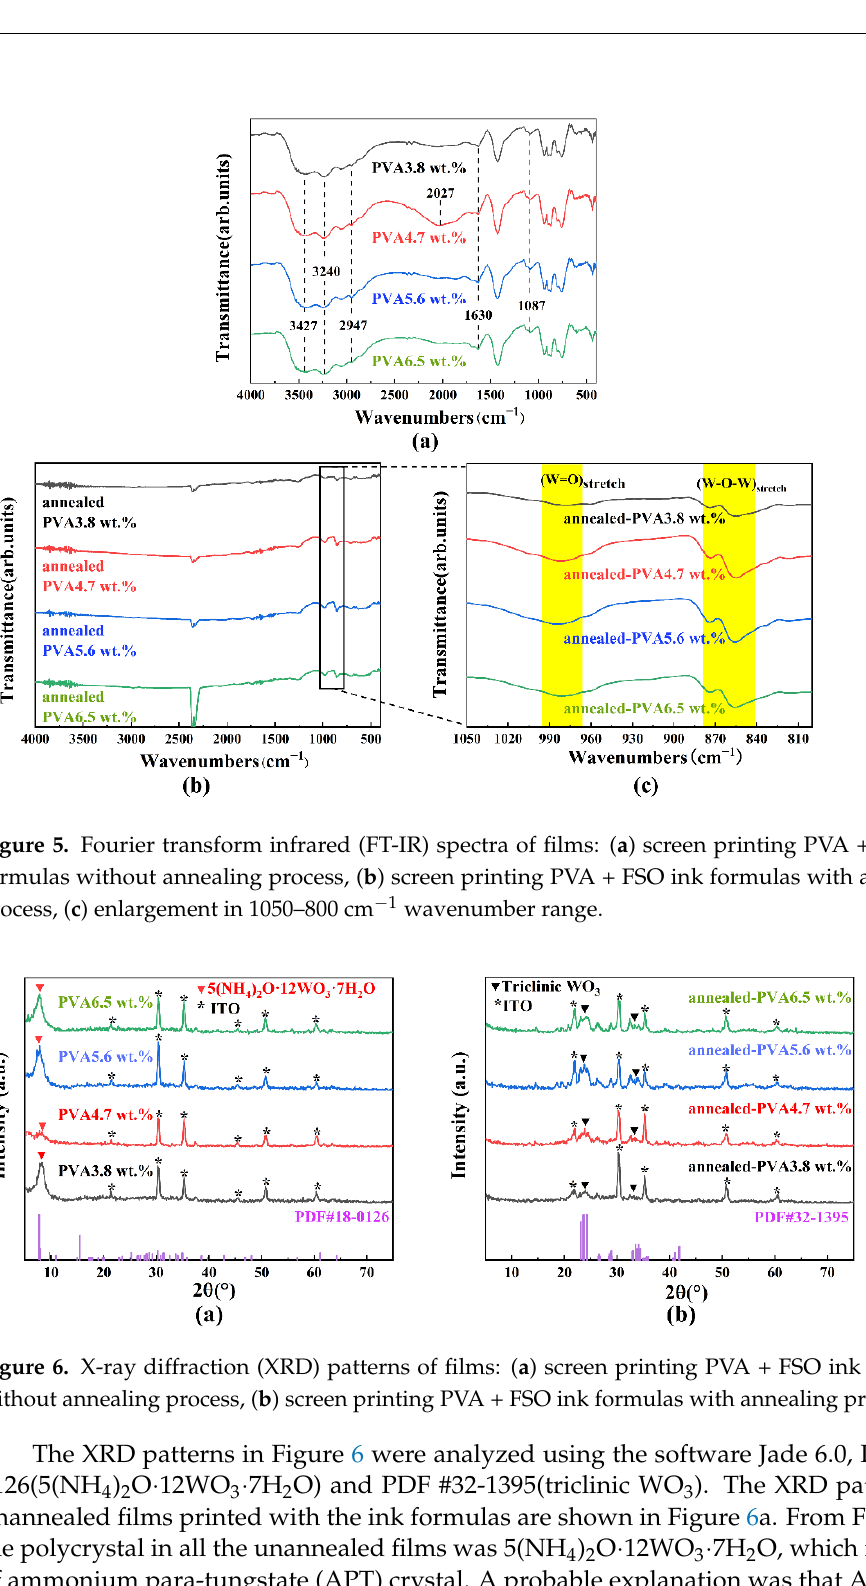
Figure 6. X-ray diffraction (XRD) patterns of films: ( a ) screen printing PVA + FSO ink formulas without annealing process, ( b ) screen printing PVA + FSO ink formulas with annealing process.